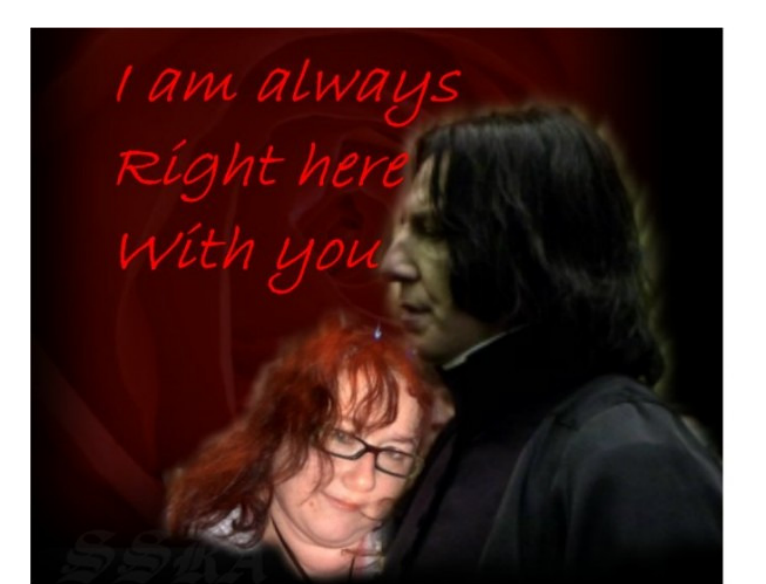
Figure 8. Photomanipulation inspired by a pillow falling on Rose as a sign of Snape’s presence